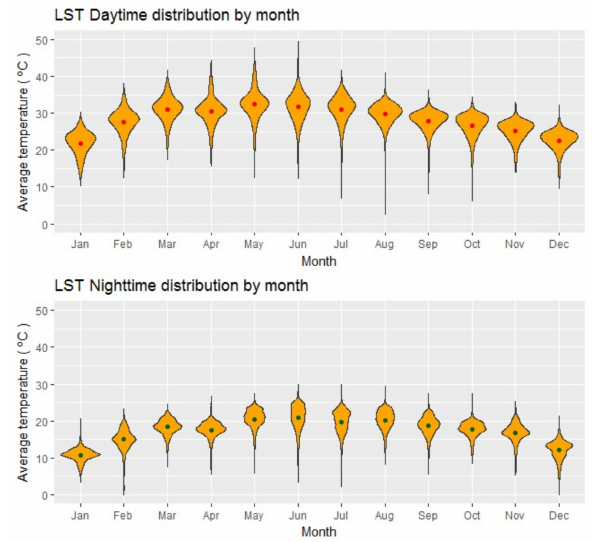
Figure 3. Violin plots show the monthly average LST of the daytime ( top ) and nighttime ( bottom ) in 2015 in northwest